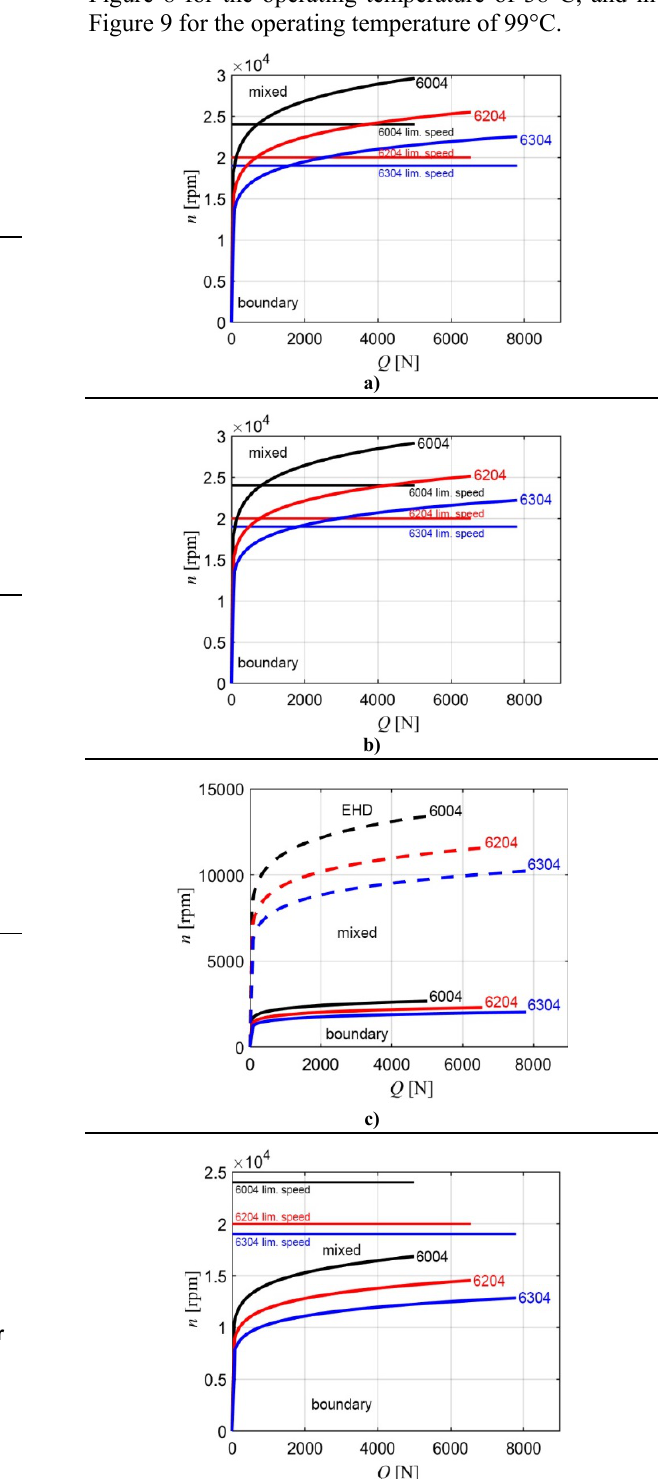
Figure 7. A plot that shows a lubrication regime dependence of the number of revolutions n and external radial load Q for particular rolling bearings and balls-inner raceway contact, with contact surfaces roughness of R ar =0.14 μ m and R ab =0.05 μ m, operating temperature of 99°C and oil lubricant: a) Advanced Ester, b) Polyalkyl Aromatic, c) Synthetic Paraffinic Oil (Lot 4), d) Super- Refined Naphthenic Mineral